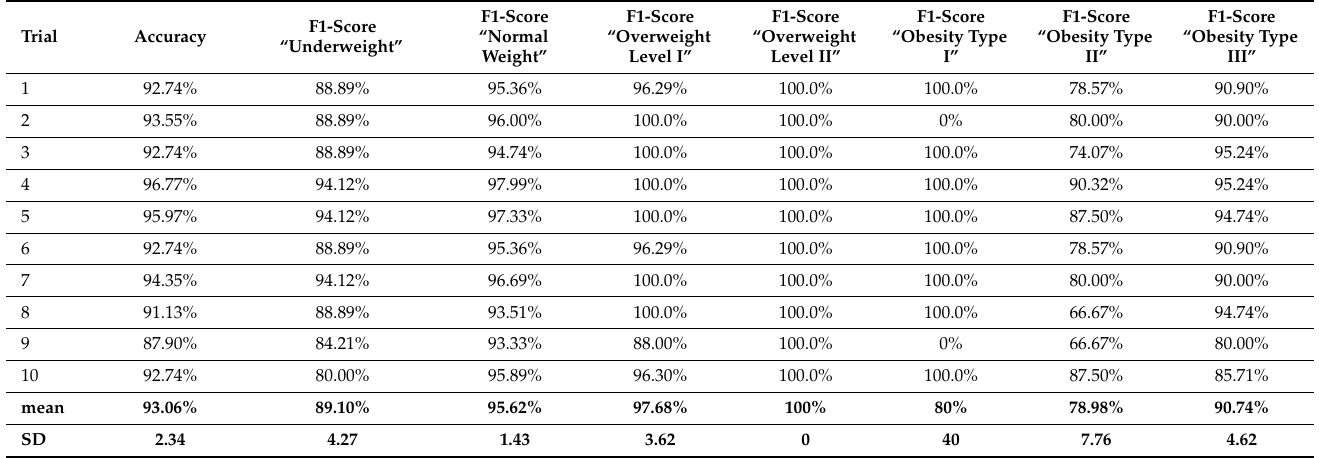
Table 4. Performance evaluation criteria for obesity prediction of the trained neural network model for each trial.